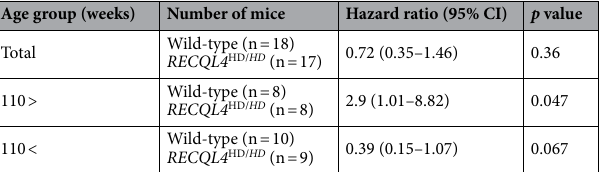
Table 1. Age-related hazard ratios (95% confidence intervals) RECQL4 HD/ HD mice compared with wild-type